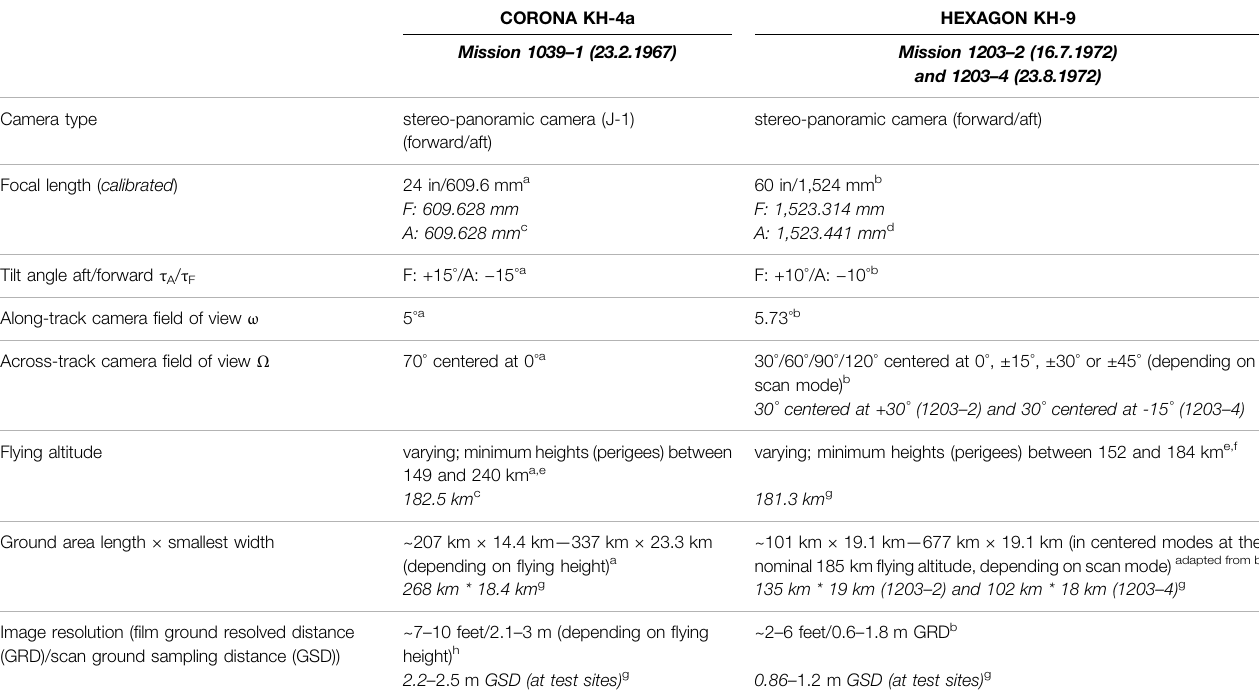
TABLE2| CharacteristicsofCORONAKH-4aandHEXAGONKH-9stereo-panoramiccamerasystemsandimages.Italicentriesareparametersthatarespeci fi ctothedata in this study and not generally applicable for all KH-4a and KH-9